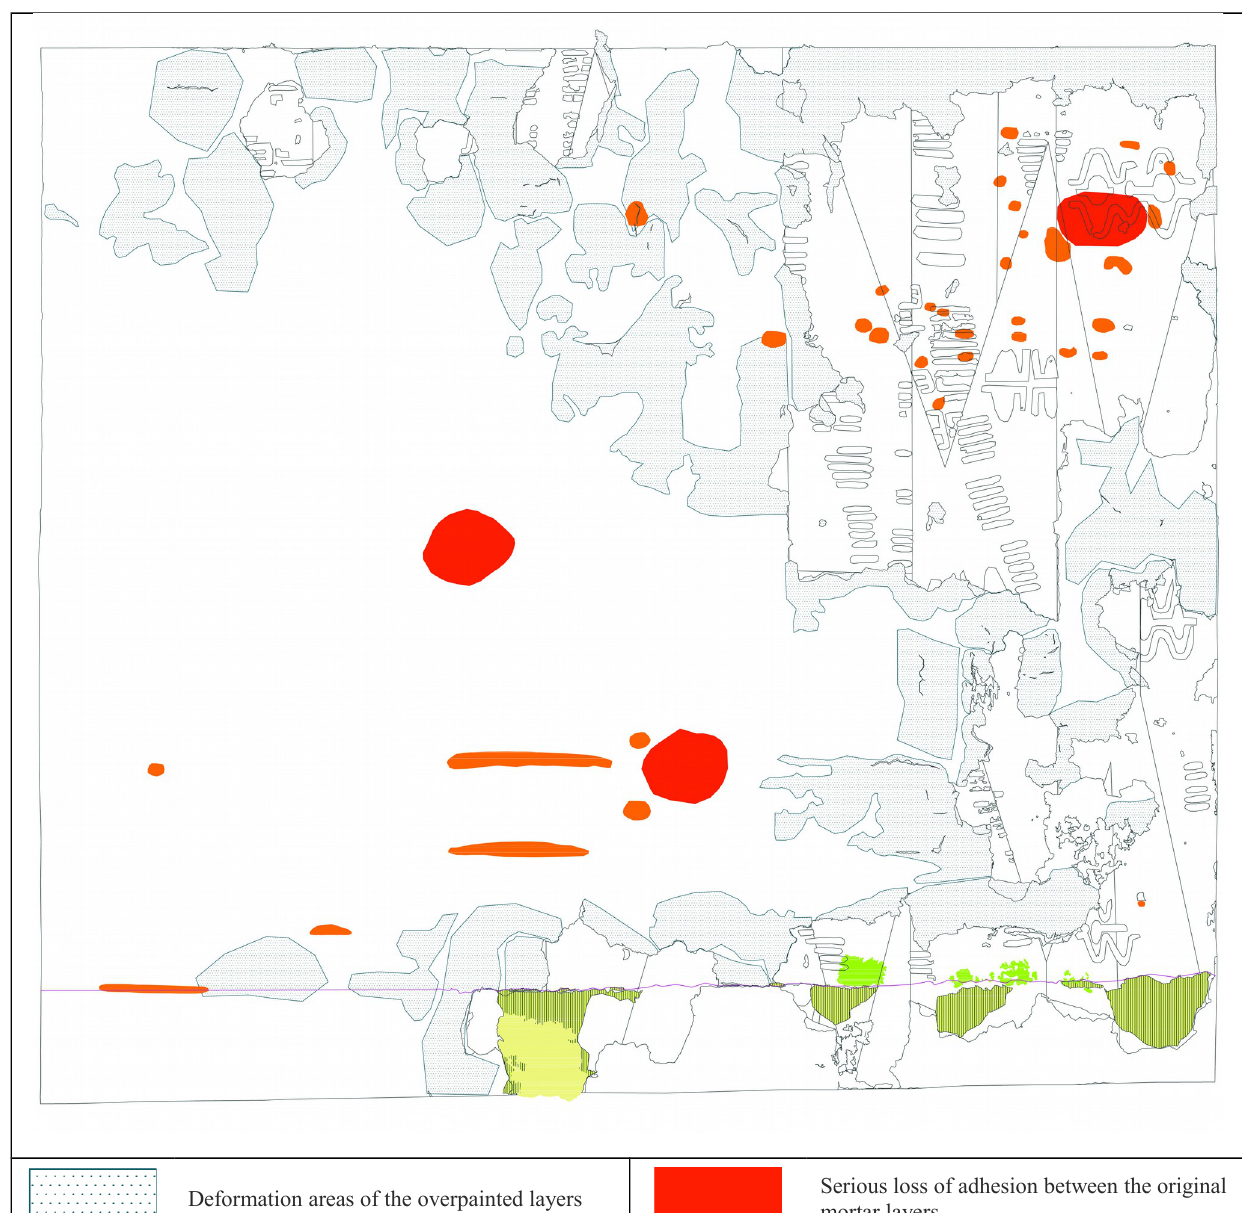
Figure 3 . Thematic graphic table of the State of Conservation (A) and its legend. Image: Paola Mezzadri all rights